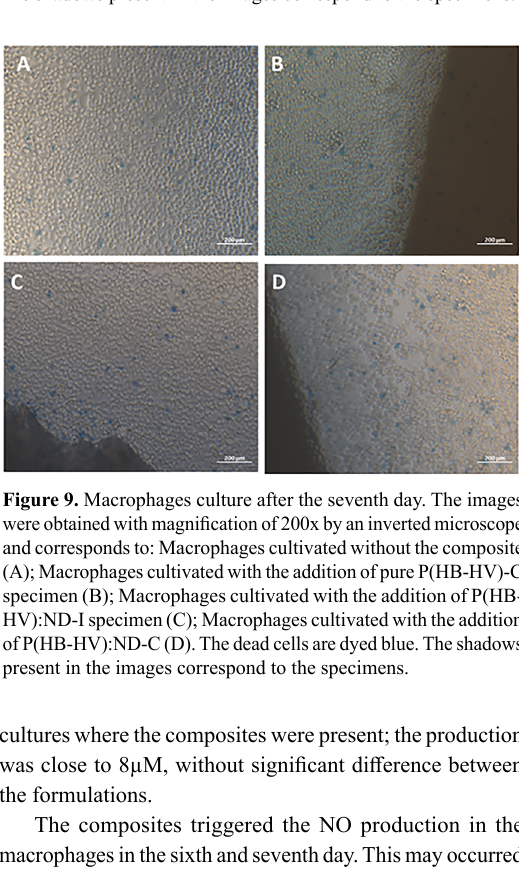
Figure 8. Macrophages cultures after the first day. The images were obtained with a magnification of 200x by an inverted microscope and corresponds to: Macrophages cultivated without the composite (A); Macrophages cultivated with the addition of pure P(HB-HV)-C specimen (B); Macrophages cultivated with the addition of P(HB- HV):ND-I specimen (C); Macrophages cultivated with the addition of P(HB-HV):ND-C (D). The red circle indicated the macrophages adhered to loose fragment from the P(HB-HV):ND-I specimen. The shadows present in the images correspond to the specimens.